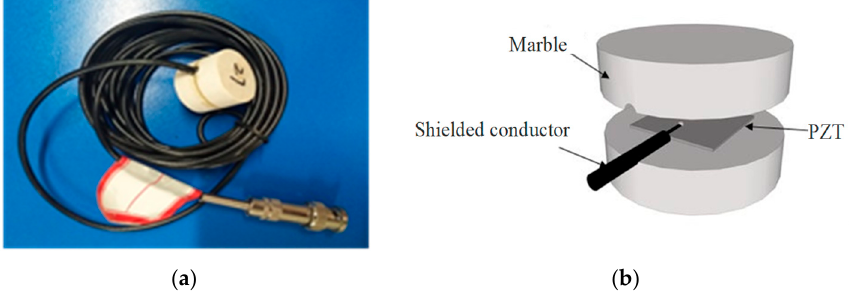
Figure 1. The embeddable piezoceramic smart aggregate. ( a ) The photo of a piezoceramic smart aggregate; ( b ) Three-dimensional schematic of a piezoceramic smart aggregate.